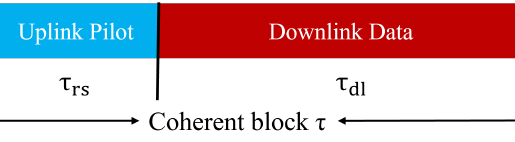
Figure 2. Coherent block